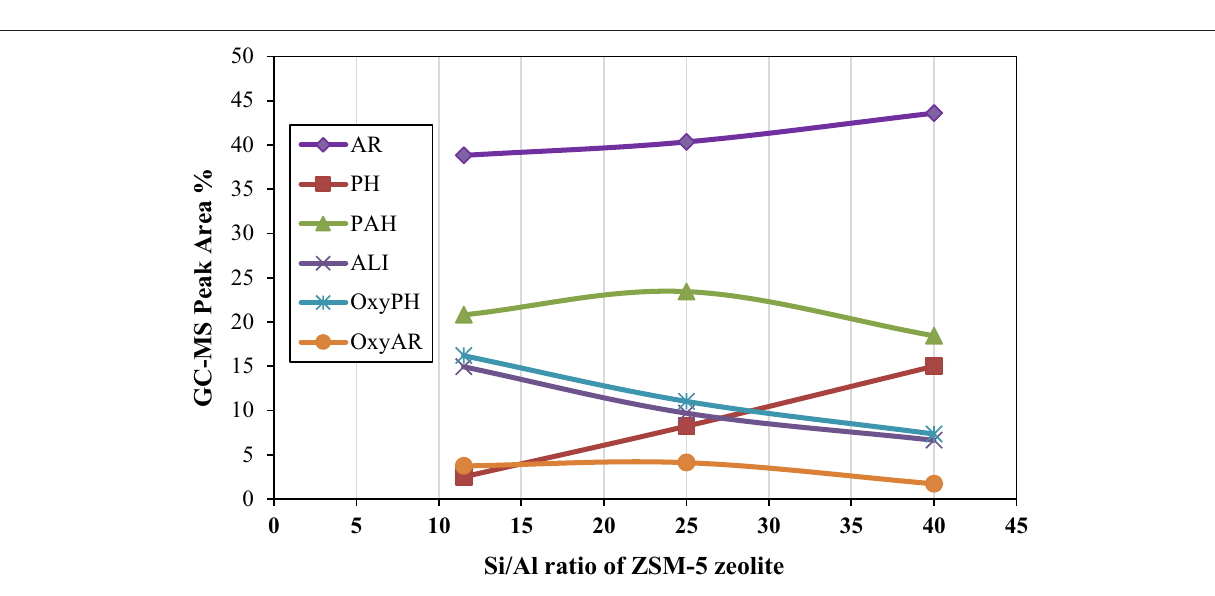
further reduced to 20.3 wt.% (the organic fraction dropped to